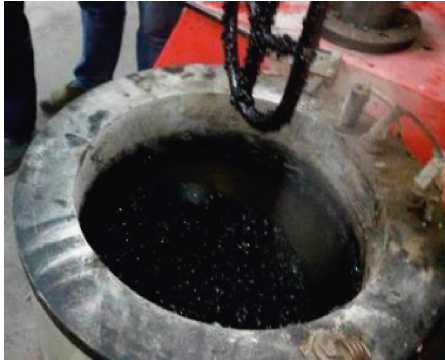
Figure 5: Mixing the hard sandstone asphalt mixture.